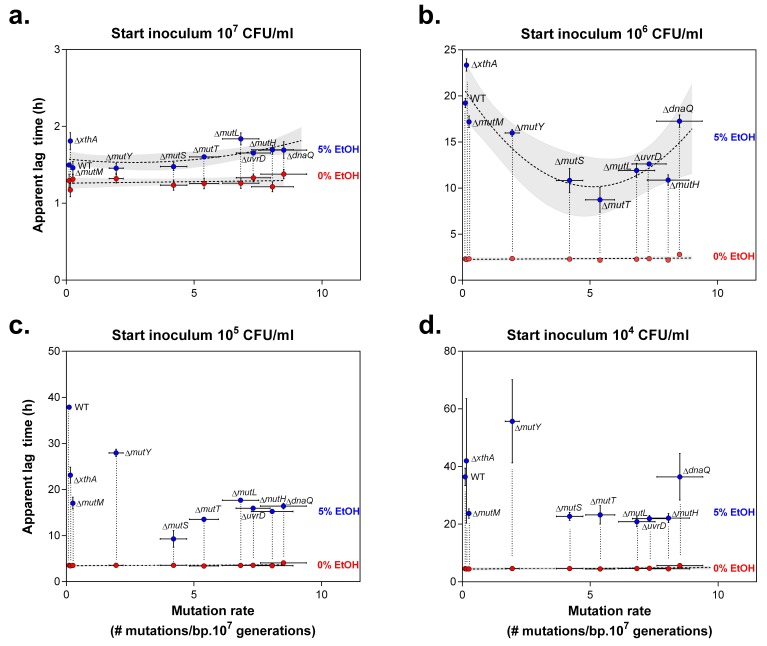
Lag times reveal a window of optimal mutation rates for growth in the presence of 5% EtOH.The vertical axis shows the lag time of wild type and mutator mutants for growth under 0% EtOH () and 5% EtOH () (mean ± 95% c.i., n = 3, values extracted from sigmoidal fitting, see Equation 1 in Materials and methods). The horizontal axis shows the absolute mutation rate for each tested strain (mean ± 95% c.i.). In the case of a large initial population, size (a) the lag times of most mutants under 5% EtOH did not differ significantly (repeated measures ANOVA with post hoc Dunnett correction), even though an inverse parabolic equation could be fitted on the data (dashed line, shading = 95% c.i.). The lag times in the absence of EtOH were linearly fitted (dashed line, shading = 95% c.i.). A 10-fold smaller initial population size (b) demonstrates the range of optimal mutation rates, reflected by a lower lag time compared to the wild type (inverse parabolic fit, shading = 95% c.i.). Interestingly, mutation rates associated with ∆mutS and ∆mutT are best suited for growth on 5% EtOH. The range of optimal mutation rates was also observed in the case of lower initial population sizes (c and d), although the inverse parabolic fit was less accurate. The lag times in the absence of EtOH were linearly fitted (dashed line, shading = 95% c.i.). When starting from a very small initial population size (d), most mutators have a lower lag time than the wild type, demonstrating that even a small increase in mutation rate (i.e. ∆mutM) is sufficient for a competitive advantage over the wild type. Only the lag times of the wild type, ∆xthA and ∆dnaQ are high, showing that mutation rates that are either too low or too high are not beneficial under these conditions. Finally, the ∆mutY mutant showed a higher lag time, possibly due to direct effects of a mutY deletion under EtOH stress.